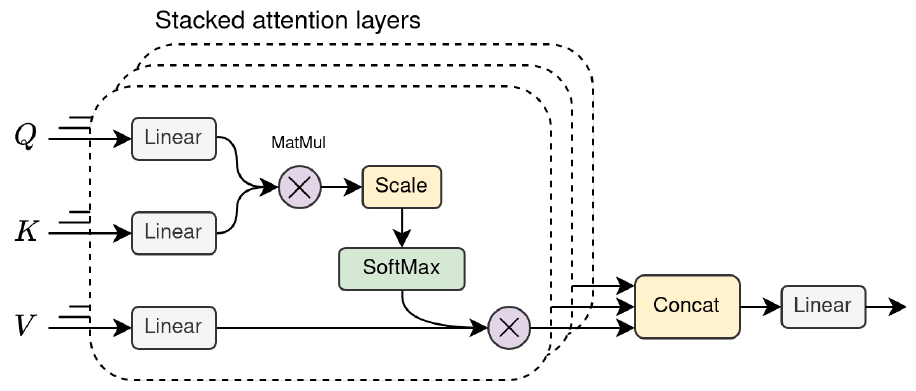
Figure 5. The multi-head attention layer used in the Transformer